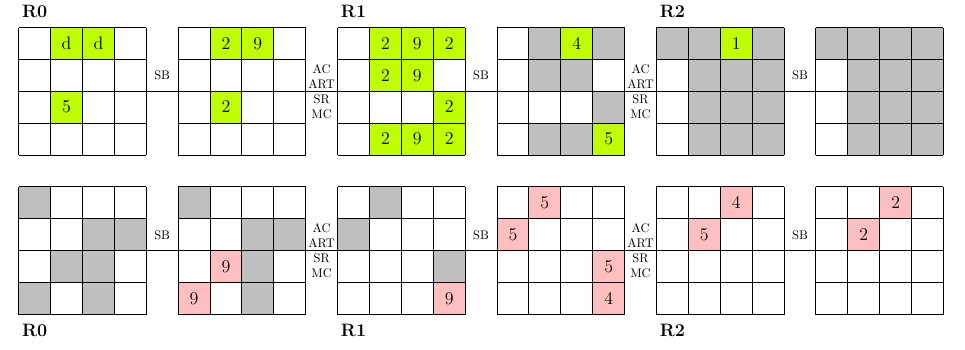
Figure 3: Toy example of boomerang characteristic on three rounds of skinny -64 in the SK